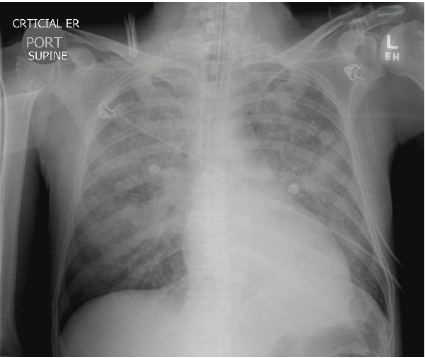
Figure 1: Initial CXR showing extensive bilateral infiltrates.